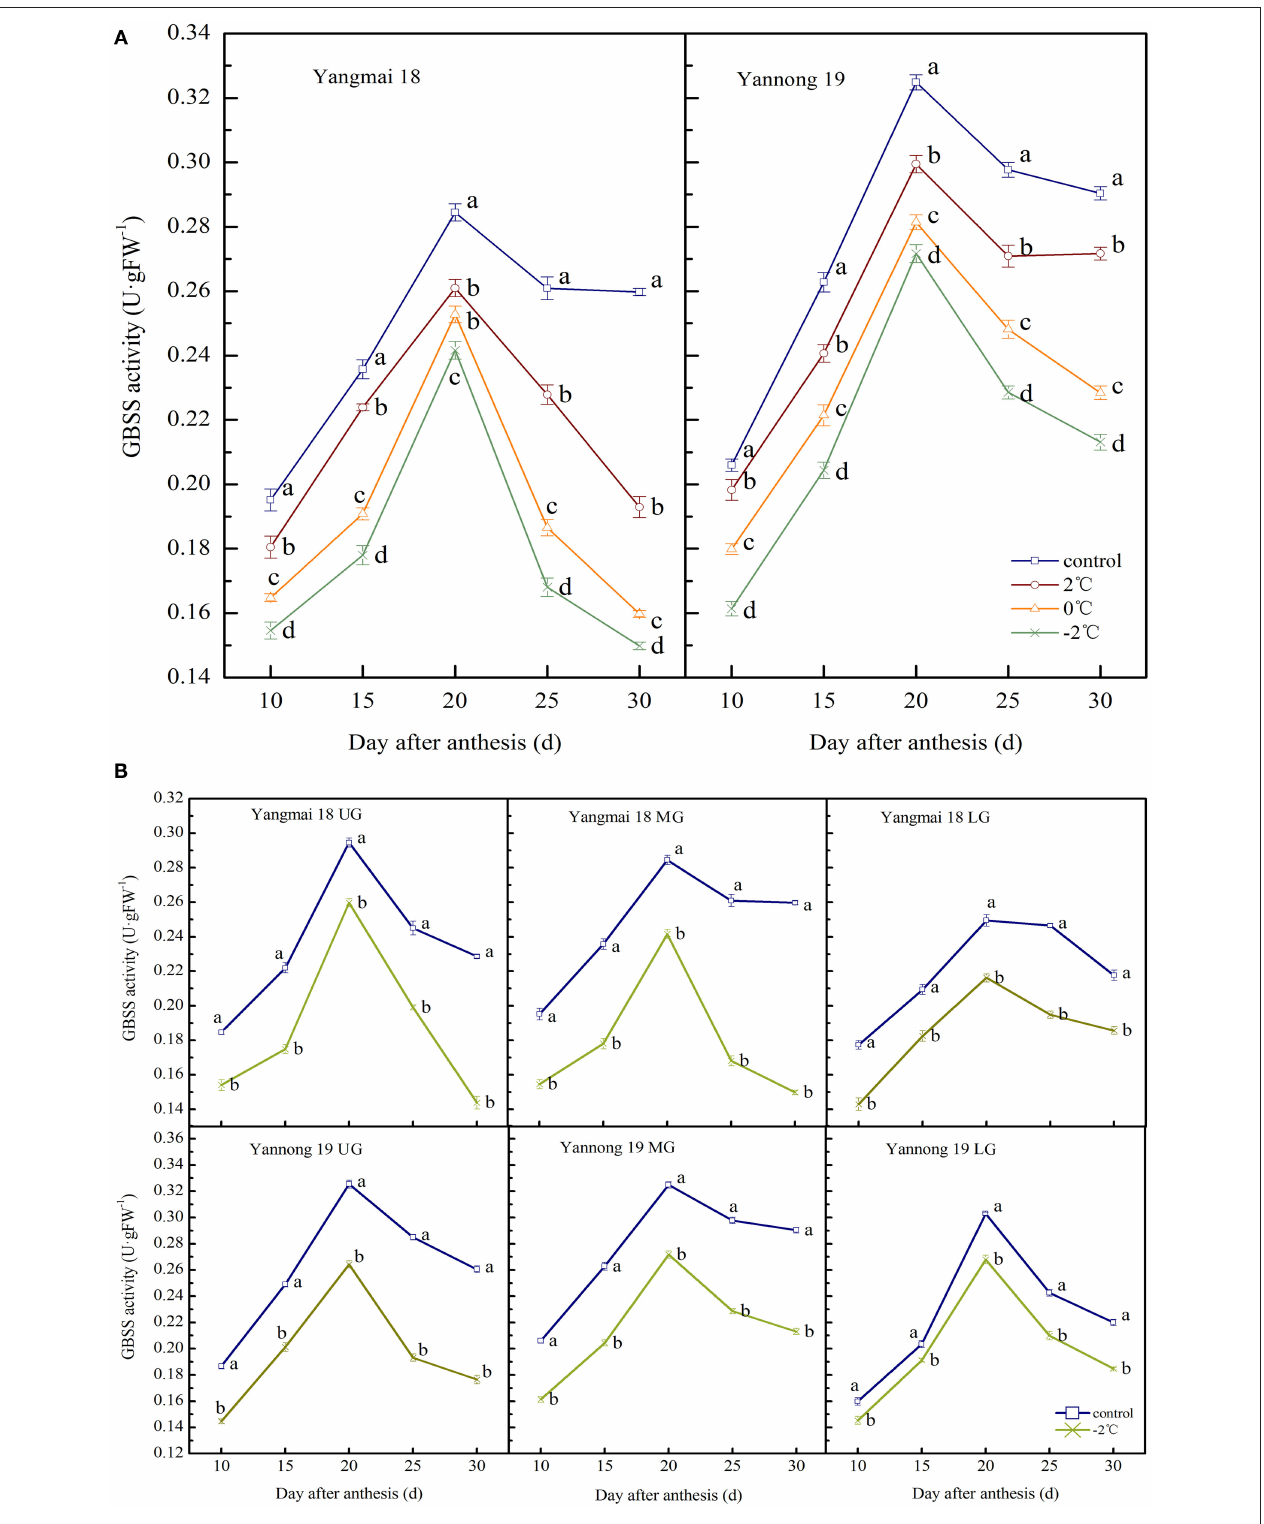
FIGURE 5 | The effect of short-term LT at the booting stage on the granule-bound starch synthase activity of wheat grain in the middle spikelets (A) and different position spikelets (B) . UG, grains in the upper spikelets; MG, grains in the middle spikelets; LG, grains in the lower spikelets. At the booting stage, the wheat